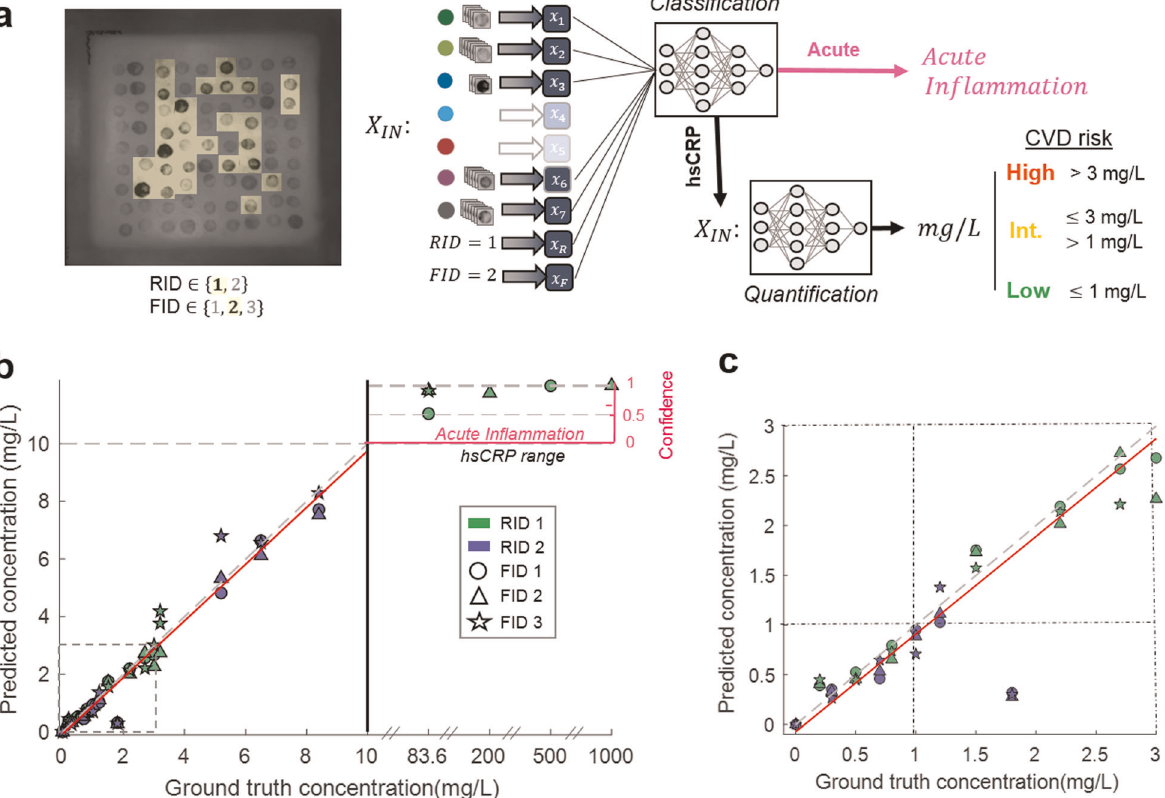
Fig. 3 Blind testing results of clinical samples ( N test = 57). a The features selected from the cross-validation analysis are extracted from a blind testing image and input into the neural network-based processing which infers the fi nal CRP concentration. The clinical cutoffs for stratifying patients in terms of cardiovascular disease (CVD) risk are shown on the right. b The ground truth CRP concentration plotted against the VFA predicted CRP concentration (left y -axis) from blindly tested clinical samples. The dotted line represents a perfect match ( y = x ) and the red line represents the linear best fi t. The con fi dence score is plotted (right y -axis) for the samples classi fi ed as acute. The marker color and shape represent the different reagent batch ID (RID) and fabrication batch ID (FID), respectively. c The blind testing results for the low and intermediate CVD risk regimes, where the dotted lines represent the clinical cutoffs at 1 and 3